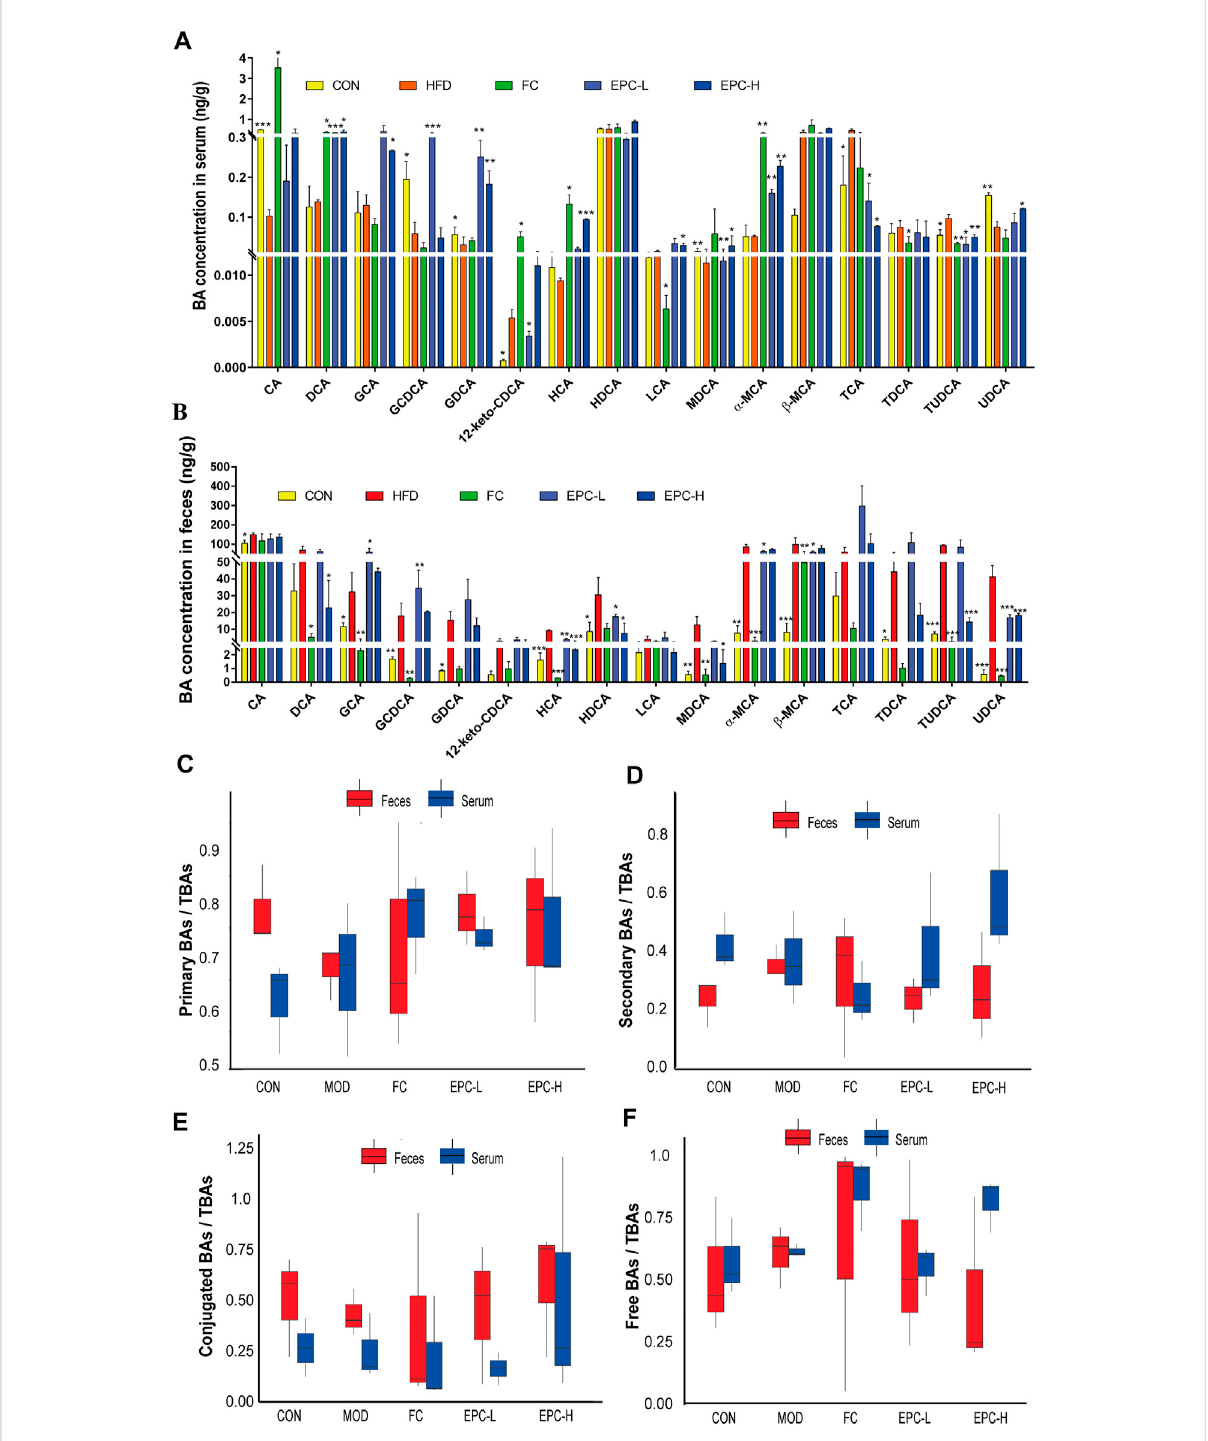
Effect of EPC on bile acid pro fi les in serum and feces. (A) BAs concentration in serum. (B) BAs concentration in feces. (C) Serum and fecal primary BAs concentration/serum and fecal TBAs concentration box chart. (D) Serum and fecal secondary BAs concentration/serum and fecal BAs concentration box chart. (E) Serum and fecal concentrations of conjugated BAs/serum and fecal TBAs concentrations box chart. (F) Free BAs concentration in serum and feces/serum and fecal BAs concentration box chart. n = 3, data are presented as mean ± SEM. CA, 12-keto-CDCA, HDCA, MDCA, and TCA in serum and GDCA, MDCA, HDCA, TDCA in feces by Tukey ’ s post hoc test. The rest of the data were tested using paired Student ‘ s t -tests. * p < 0.05, ** p < 0.01, *** p < 0.001 vs MOD group. CA, cholic acid; GCDCA, glycine (G)-chenodeoxycholic acid; GDCA, G-deoxycholic acid; MDCA, murideoxycholic acid; UDCA, ursodeoxycholic acid; TUDCA, taurine (T)-UDCA; HCA, hyocholic acid; HDCA, hyodeoxycholic